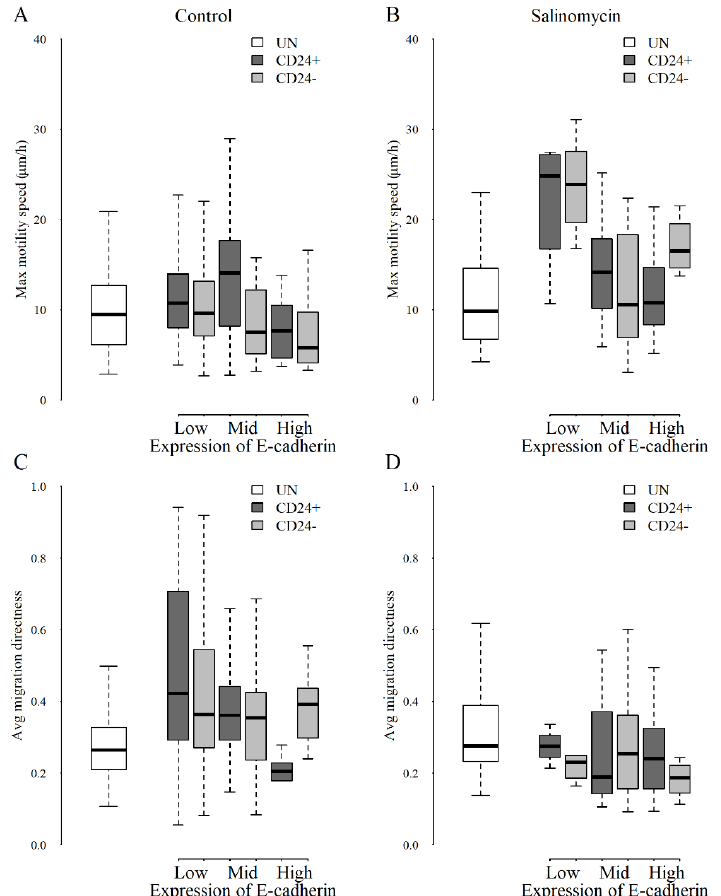
Figure 3. Movement behavior of JIMT-1 cells cultured in the absence or presence of 0.5 µ M salinomycin. The cells were imaged using time-lapse digital holographic imaging for 48 h starting immediately after treatment. After time-lapse imaging, the cells were fixed and stained for the expression of CD24 and E-cadherin and fluorescence images were acquired at the same field of view as the time-lapse. The tracked cells from the time-lapse were characterized as being either CD24 + or CD24 − and the E-cadherin expression was characterized as low, medium, or high, resulting in six groups. The cells that were tracked but that were not present in the last frame of the DHM time-lapse are called unknown (UN). Max motility speed ( A , B ) is the accumulated distance over the time of treatment (max motility) divided by the time of tracking. Average migration directness ( C , D ) is the migration, i.e., the shortest distance between the starting point of the tracking and the end point of the tracking, divided by motility. ( A ) Significant di ff erences for the max motility speed was found between the CD24 + and CD24 − populations ( p = 0.0008) of the control, and between cells with low or high expression of E-cadherin ( p = 0.007). There was also a significant di ff erence between CD24 + E-cad mid cells and CD24 − E-cad mid cells ( p = 0.002). ( B ) Significant di ff erences for max motility speed for the salinomycin-treated sample were found between cells with low or medium expression of E-cadherin ( p < 0.0001), as well as those with high expression ( p < 0.0001). There was also a significant di ff erence between CD24 − E-cad low cells and CD24 − E-cad mid cells ( p < 0.0001). ( C ) For average migration directness, significant di ff erences were foundcomparingcellswithlowE-cadherinexpressioncomparedtomediumexpression( p -value = 0.008), and for CD24 + E-cad low cells compared to CD24 + E-cad high ( p = 0.004). ( D ) No significant di ff erences in average migration directness were found for the di ff erent groups of salinomycin-treated cells. ( A , B ) Salinomycin treatment significantly increases the max motility speed in all three E-cadherin groups (low: p < 0.0001, mid: p < 0.01, and high: p < 0.0001) compared to control. ( C , D ) Salinomycin treatment significantly decreased the average migration directness for cells with low E-cadherin expression ( p < 0.0001) and mid E-cadherin expression ( p < 0.001). All statistics were evaluated using a one-way ANOVA and Tukey honest significant di ff